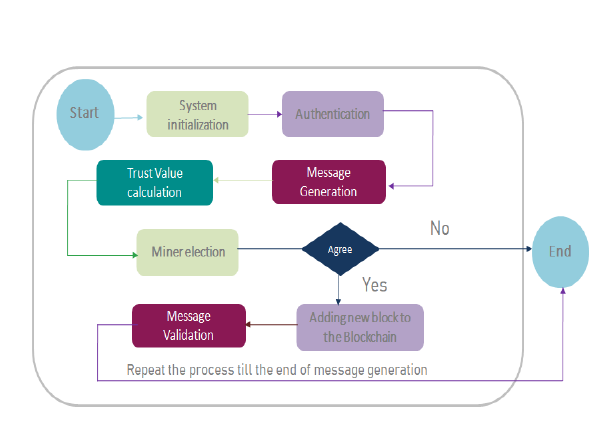
FIGURE 5. THE PROPOSED